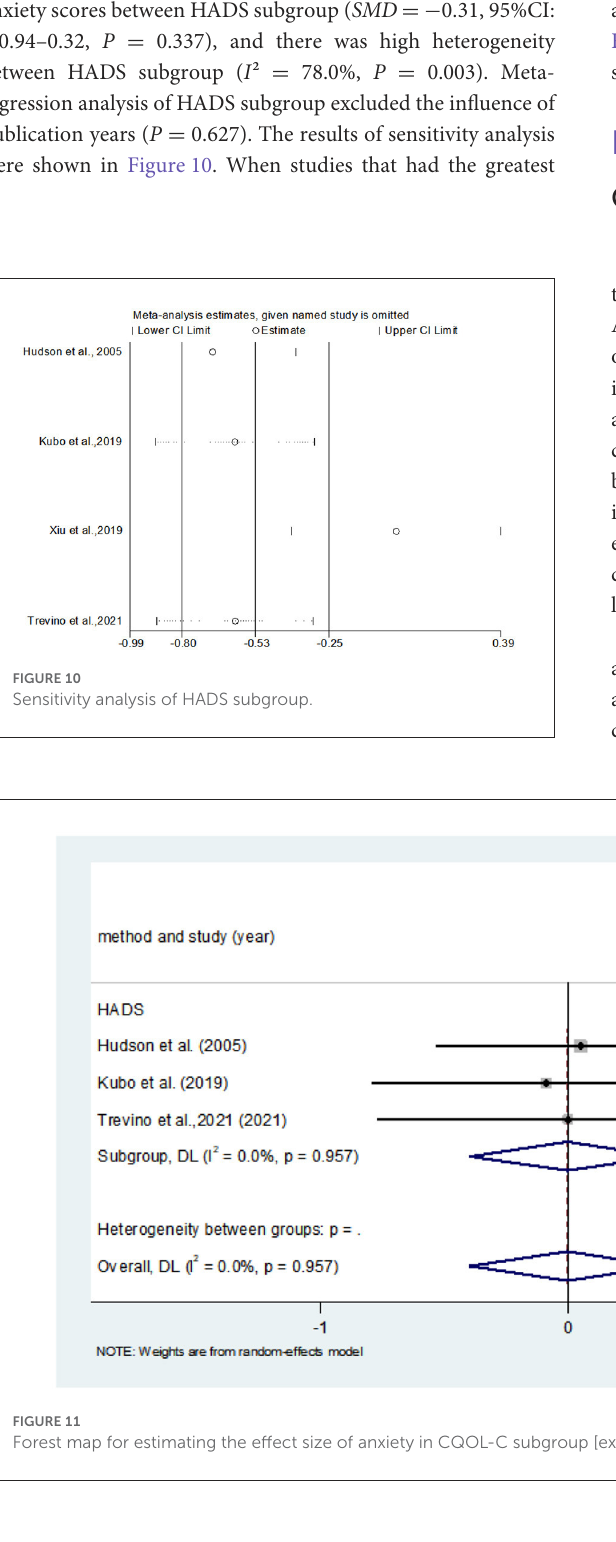
Figure 11. Egger’s test results are shown in Figure 12, without